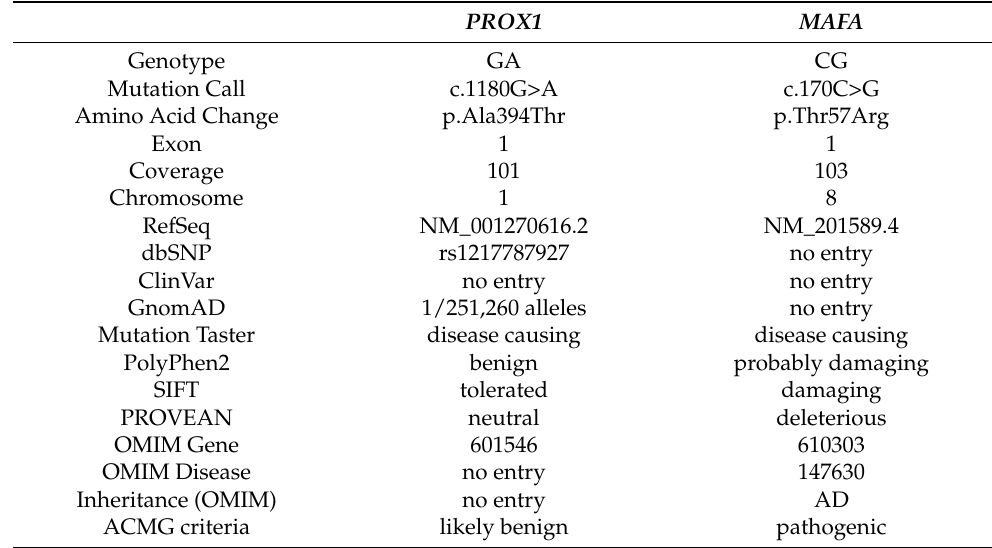
Table 1. Comparison and classification of the potentially disease-causing variants in PROX1 and MAFA genes detected by WES and variant filtering. PROX1 MAFA